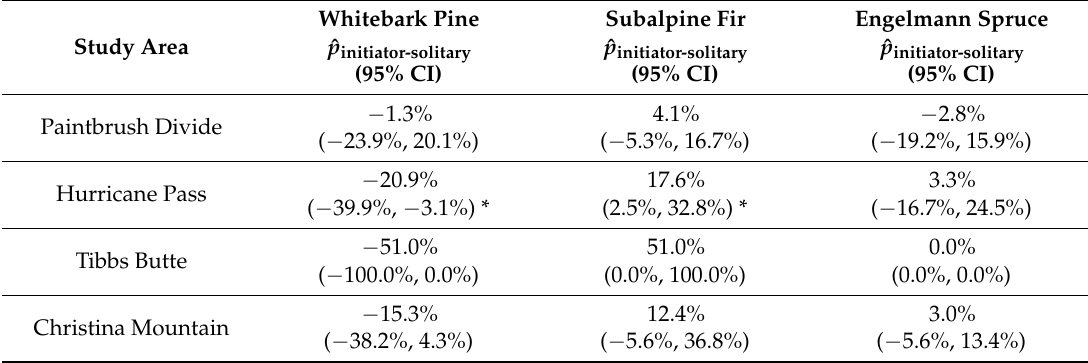
Table 5. Mean difference between tree island initiator and solitary conifer relative abundance by species parameter estimates.